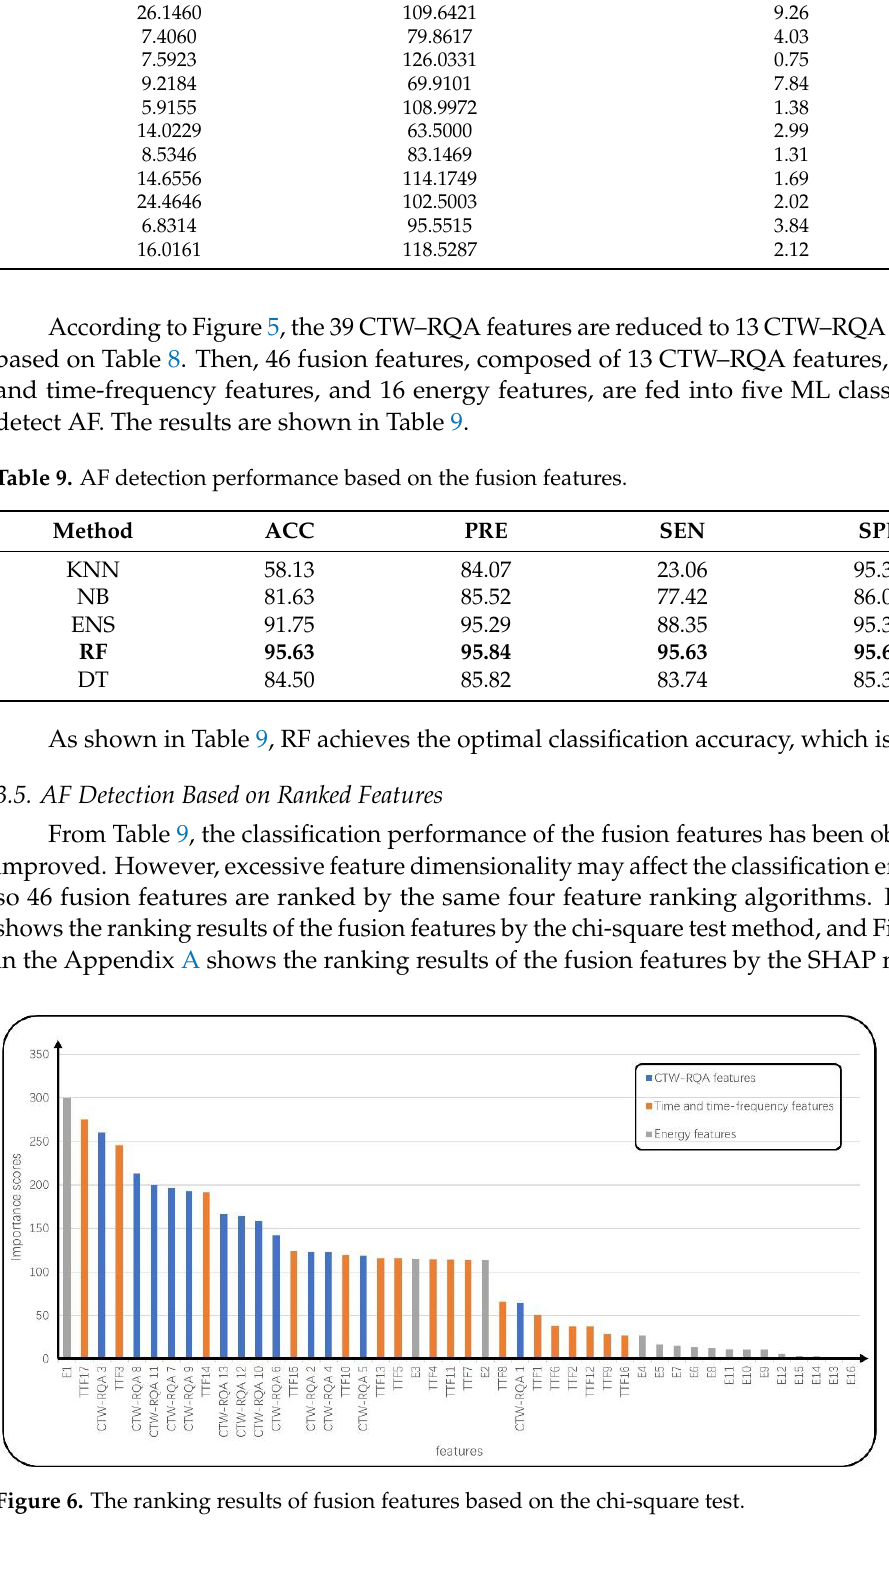
Table 10. AF detection accuracy based on the ranked features. Method